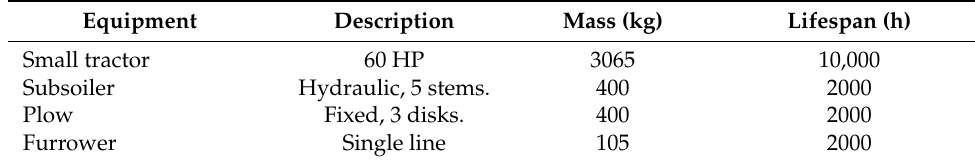
Table 3. Data for E M